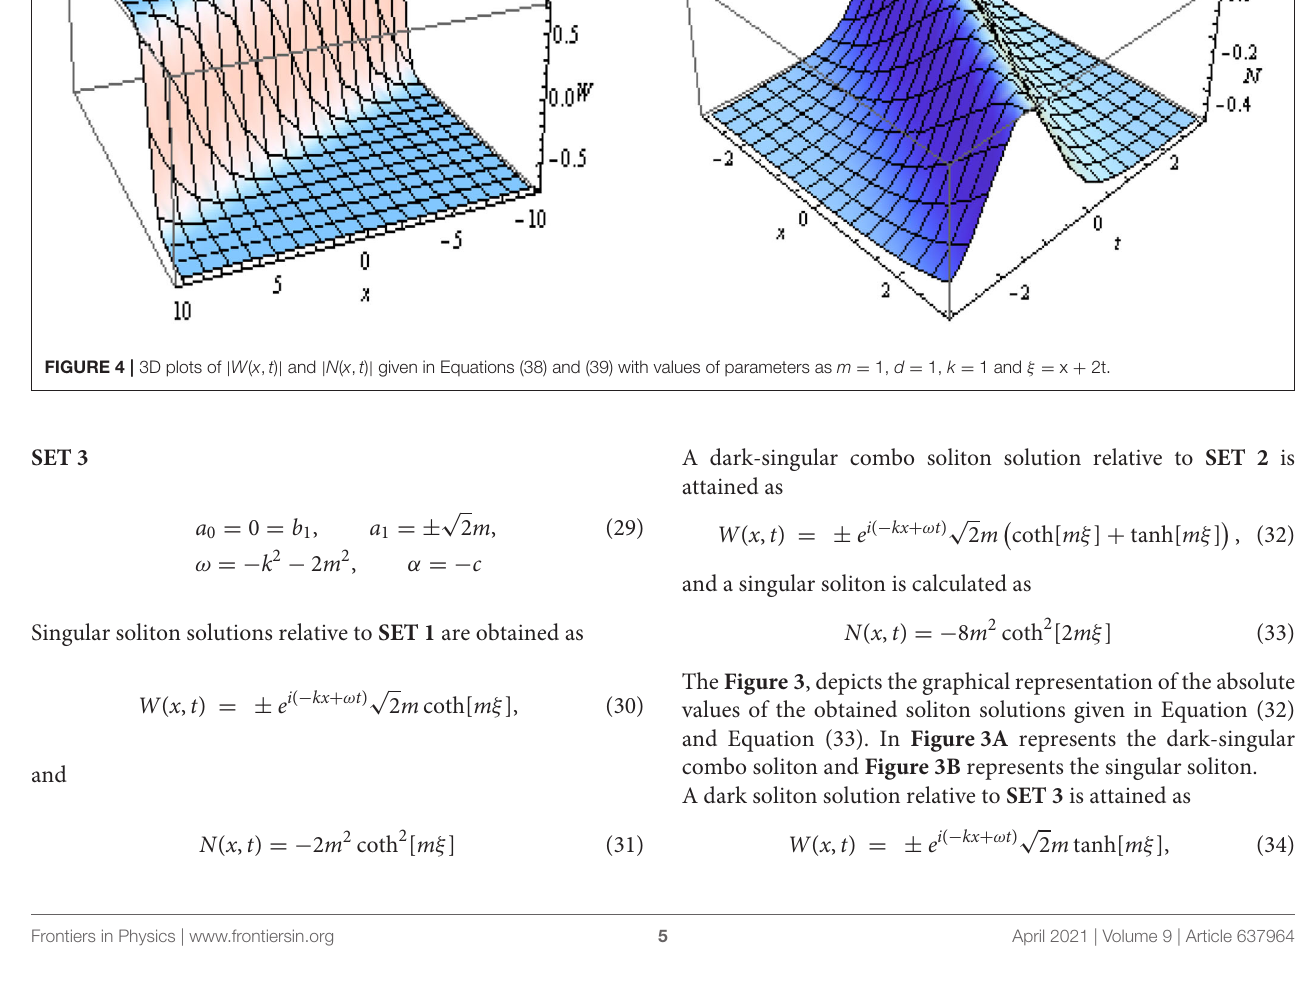
FIGURE 4 | 3D plots of